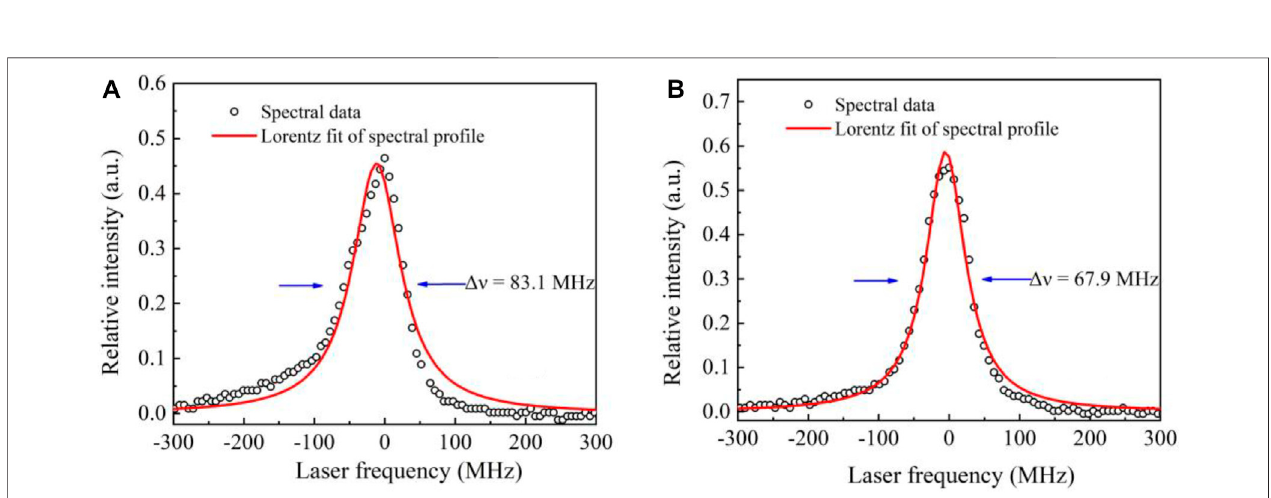
FIGURE 10 | Spectral pro fi le of MOPA output at the 100-kHz repetition rate. (A) For 1.08 mJ single-pulse energy output with a pulse width of 10.3 ns. (B) At 4.38 mJ single-pulse energy output with pulse duration of 96.1 ns.